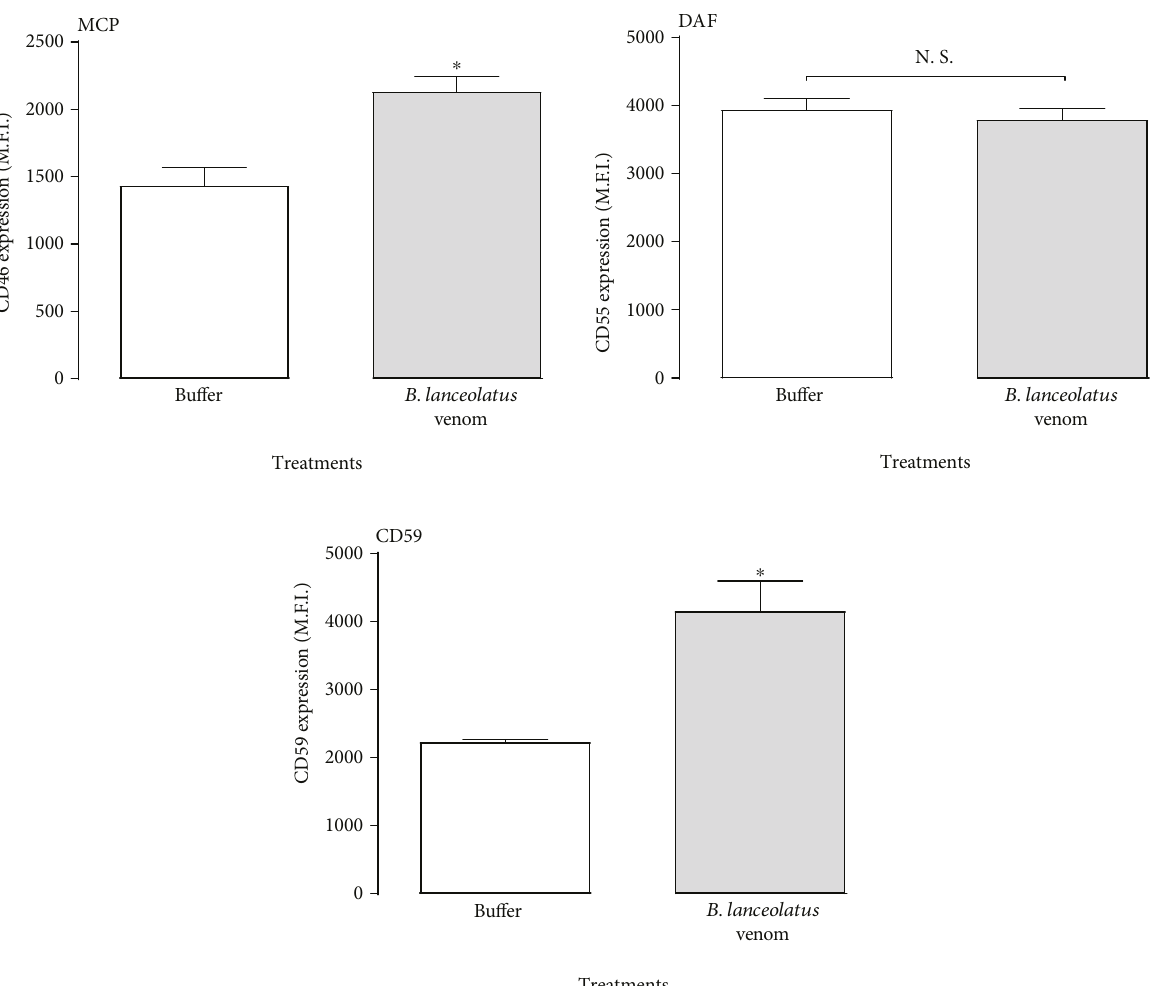
Figure 5: E ff ect of B. lanceolatus venom exposure on C-regulator expression on endothelial cells. EA.hy926 cells (10 6 cells/mL) were incubated with B. lanceolatus venom (100 μ g/mL) for 2 h. After incubation with DAF-, MCP-, and CD59-speci fi c antibodies, the fl uorescence was assessed by fl ow cytometry. The results are representative of two experiments, carried out in triplicates. Data are represented as mean ± SD. ∗ p < 0 05 compared to the bu ff er-treated controls. # p < 0 05 between two